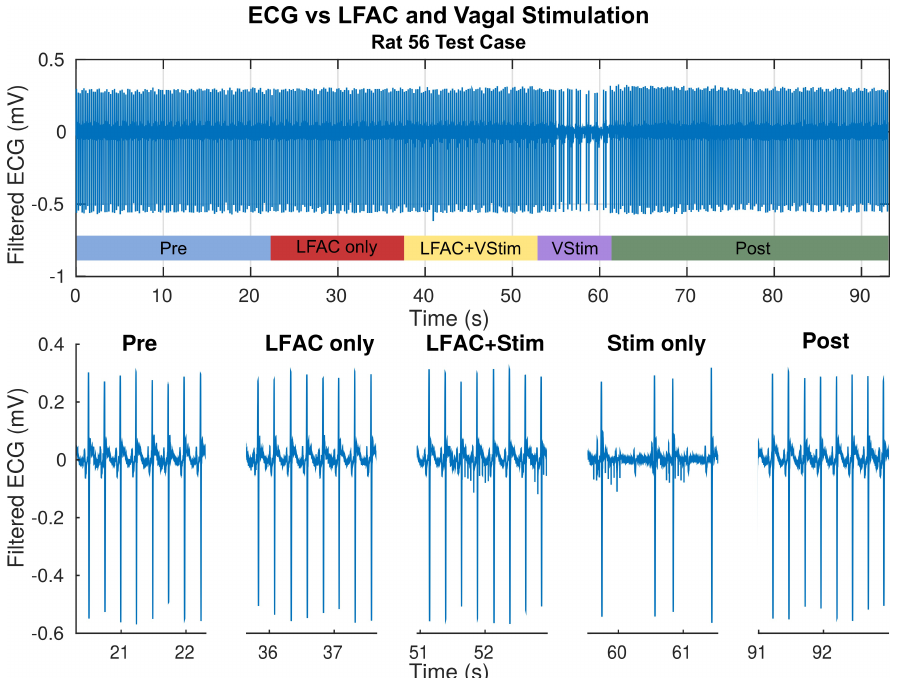
Figure 2. The effect on heart rate during a test sequence consisting of (1) Pre (no stim), (2) LFACb only, (3) LFACb and Vagal Stimulation delivered together, (4) Vagal Stimulation only, and (5) Post (Recovery, no stim or LFACb). The top panel shows a continuous recording of the bandpass filtered ECG during the five epochs. The bottom panels show 2 s samples of the ECG for each epoch. © 2019 IEEE. Reprinted, with permission, from